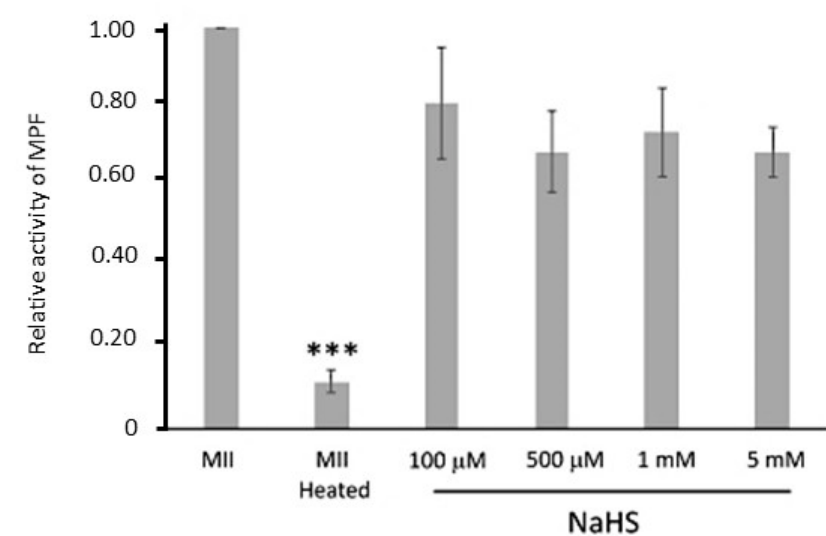
Figure 6. NaHS does not dissociate the pre-MPF complexes nor impact MPF activity. ( A ) Immunoblots of Cyclin B2, P-Tyr15-Cdk1, and total Cdk1 after Cdk1 immunoprecipitations. Protein extracts from immature oocytes (PI) were treated or not with NaHS at di ff erent concentrations (500 µ M, 1 mM, and 5 mM) for 24 h at 4 ◦ C. The protein extracts were incubated with Cdk1 antibody overnight before they were precipitated with Protein A-sepharose beads for 1 h at 4 ◦ C. Input and output lines correspond to proteins extracts without the Cdk1 antibody but before and after protein A-sepharose bead incubation, respectively. MII corresponds to protein extracts from mature oocytes. ( B ) Relative MPF activity was examined by histone H1 kinase assay after exposure of protein extracts from mature oocytes (MII) to NaHS at di ff erent concentrations (100 µ M, 500 µ M, 1 mM, and 5 mM) or heated for 30 min at 100 ◦ C. MPF activities correspond to the quantification values of p -histone H1 on H1 bands obtained by autoradiography on 3 independent experiments. Statistical significance was accepted for *** p < 0.001. N = 3; n = 15.